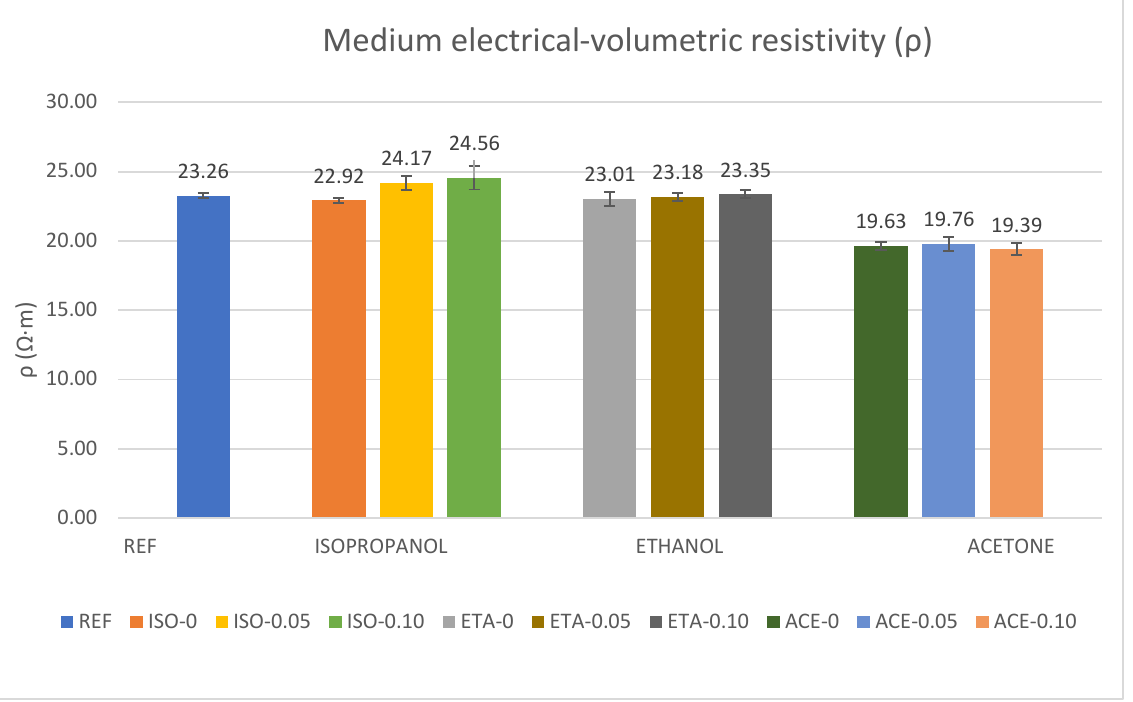
Figure 6. Results of the electrical-volumetric resistivity.